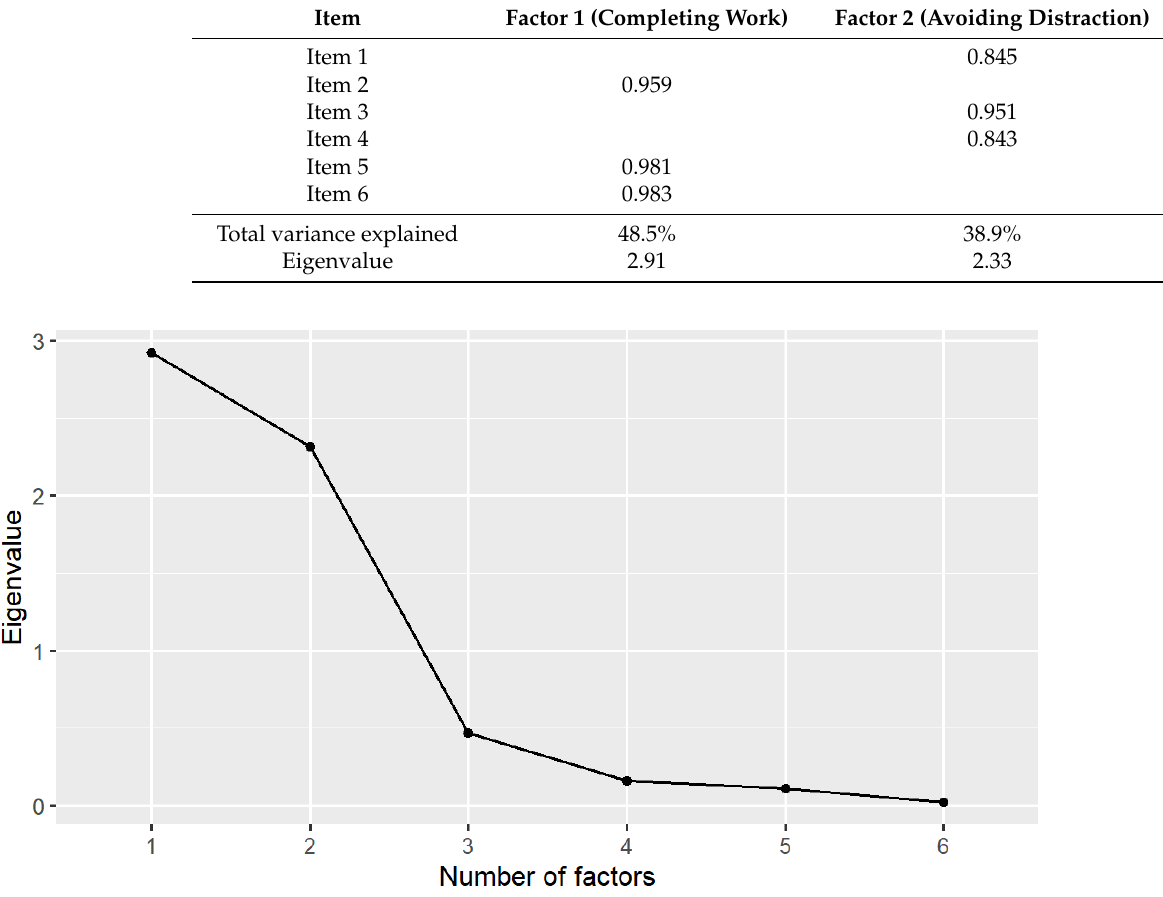
Figure 1. Scree plot of the Chinese version of the Stanford Presenteeism Scale (CSPS-6) in the exploratory factor analysis (EFA).